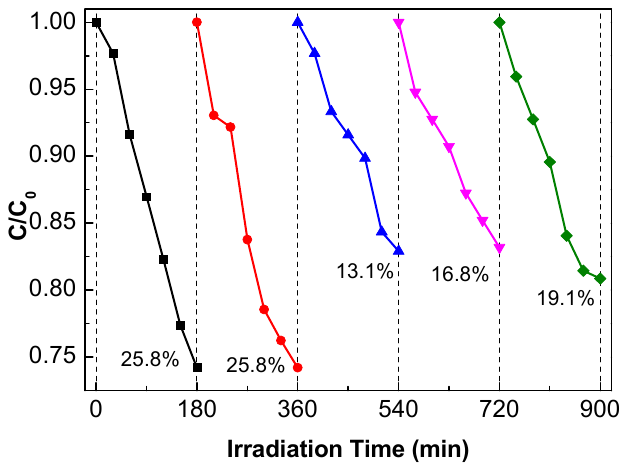
Figure 7. Cyclic stability test of the 5-layer g-C 3 N 4 (0.5) / TiO 2 photocatalytic degradation of tetracycline hydrochloride (TC-HCl).